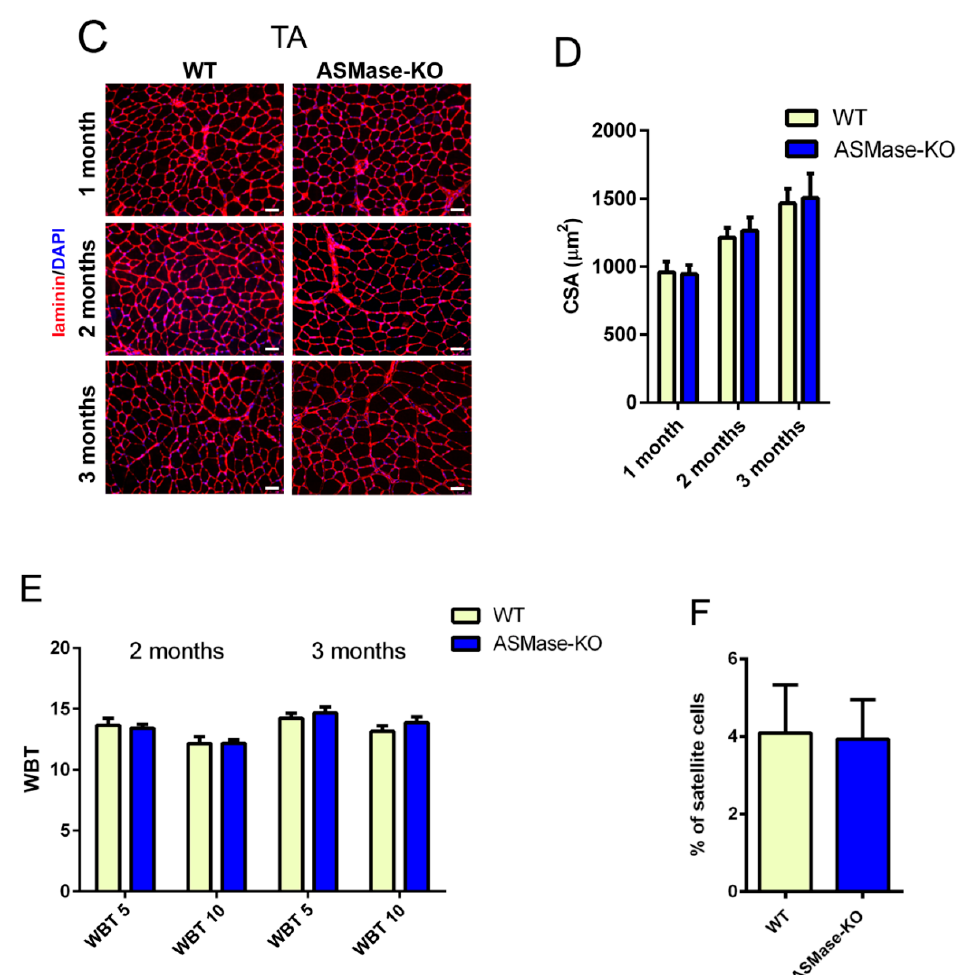
Figure 1. Characterization of skeletal muscle phenotype and function in ASMase-KO mice. ( A ) Muscle weight, normalized to body weight, of TA muscles in 1 month, 2 months and 3 months old WT and ASMase-KO mice ( n ≥ 4 mice). ( B , C ) Representative images of H&E staining ( B ), and Laminin (red) and DAPI (Blue), for the nuclei, ( C ) immunostaining of transverse sections of TA of 1 month, 2 months and 3 months old WT and ASMase-KO mice. Scale Bar, 50 μ m. ( D ) Quantification of mean CSA of TA of 1 month, 2 months and 3 months old WT and ASMase-KO mice ( n ≥ 4 mice) measured using ImageJ based on laminin staining. ( E ) WBT measurements determined by dividing the average of the top ten or top five forward pulling tensions, respectively, by the body weight in 1 month, 2 months and 3 months old WT and ASMase-KO mice ( n = 10). ( F ). Satellite cell quantification by flow cytometry in TA muscles of 3 months old WT and ASMase-KO mice ( n = 3 mice).